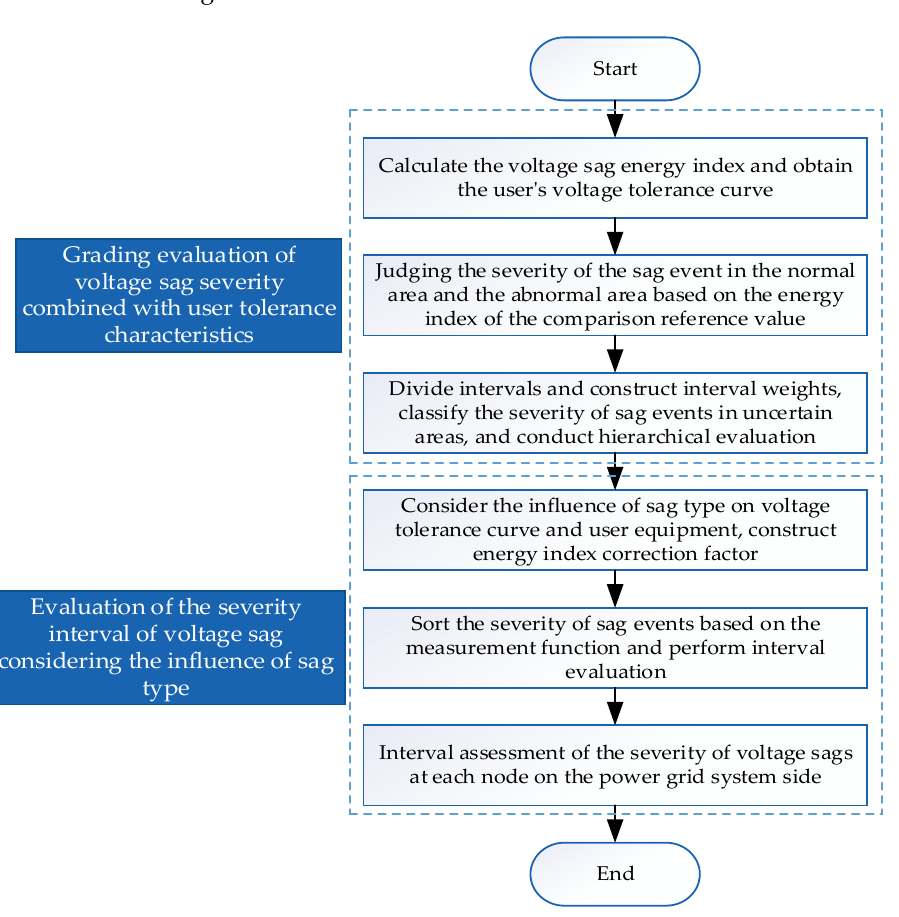
Figure 1. The overall organizational framework of the